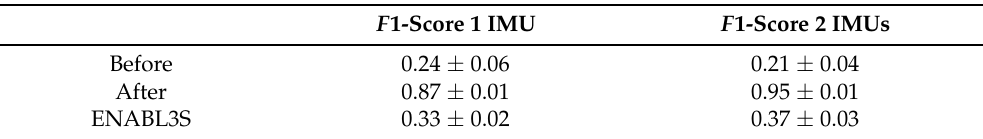
Table 6. F 1-scores obtained with the CNN-LSTM with one ENABL3S subject. The row ‘Before’ shows results obtained without the independent subject data during training, while the row ‘After’ shows results obtained with the independent subject data during training. The row ‘ENABL3S’ shows results on ENABL3S data after retraining with the MyLeg data.